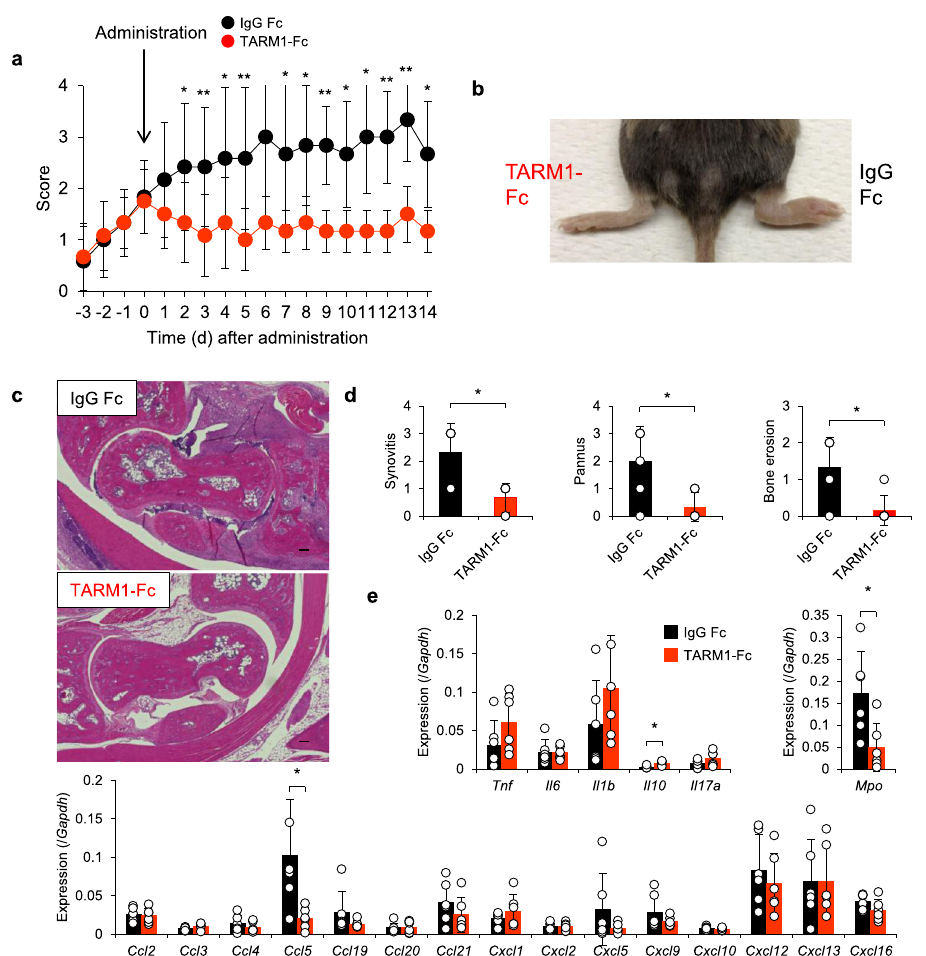
Fig. 5 Administration of TARM1-Fc attenuates the development of CIA. a Severity score of arthritic joints from CIA-induced DBA/1J mice treated with TARM1-Fc or IgG Fc. TARM1-Fc and IgG Fc (1 μ g/30 μ l for each) were administrated into the articular cavity of the left and right knee joints of a CIA- induced mouse, respectively, and the severity scores of IgG Fc- (black) or TARM1-Fc-injected paw (red) were measured separately. Data from two independent experiments are combined ( n = 12). Mean ± SD. * P < 0.05; ** P < 0.01 (two-tailed Mann – Whitney U test). b Representative photograph of feet treated with TARM1-Fc (left) or IgG Fc (right) as shown in a . c , d Histology of the HE-stained ankle joint at day 14 after TARM1-Fc or IgG Fc treatment ( c ). Data are representative of six mice. Histological score of synovitis, pannus formation, and bone erosion of ankle joints are shown in ( d ). Mean± SD. Scale bar, 100 μ m. * P < 0.05 (two-tailed Mann – Whitney U test). e Gene expressions in arthritic ankles and tarsal joints from TARM1-Fc- or IgG Fc-treated